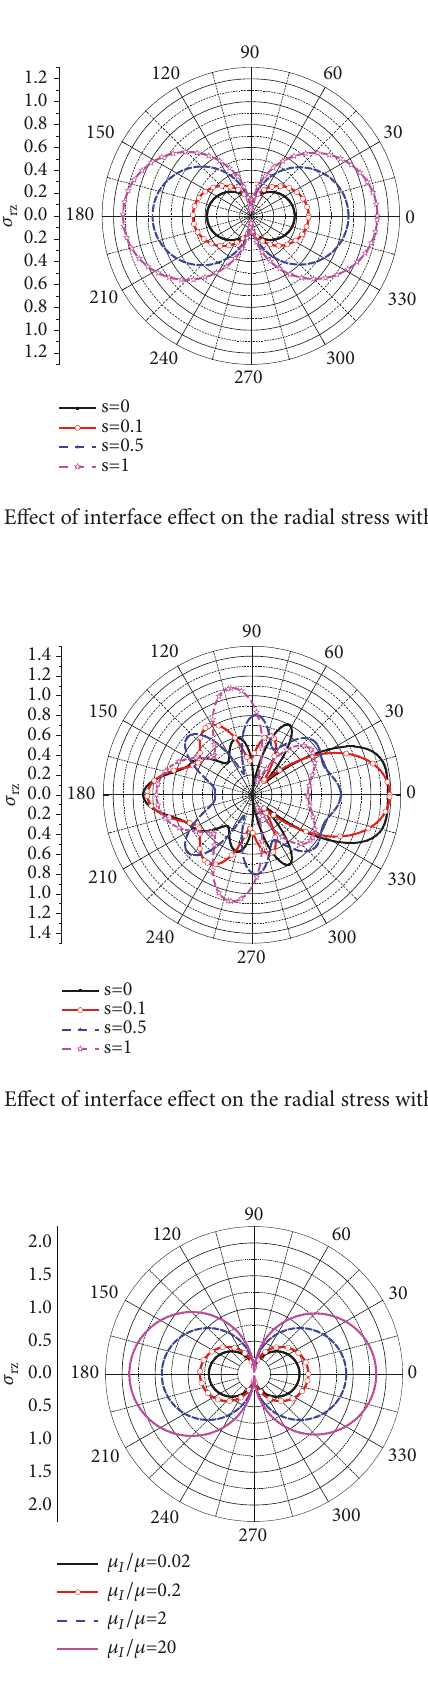
Figure 10: Effect of 𝜇 𝐼 /𝜇 on the radial stress with 𝐾 𝐼 /𝐾 = 0.2